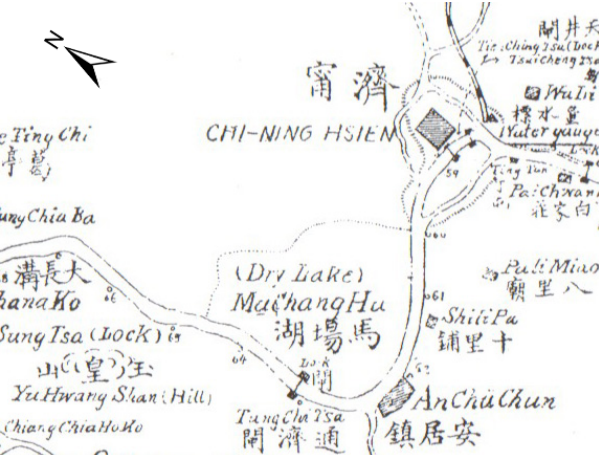
Figure 8. Part of a historical map entitled “The Plan of the South- ern Part of the Grand Canal, Including the Shallow Lakes and Swamps” (Pan, 1916; see Fig. S1 for the whole map), showing the area near Lake Machang. Lake Machang was noted as a “dry lake” and Machang Hu (Hu means